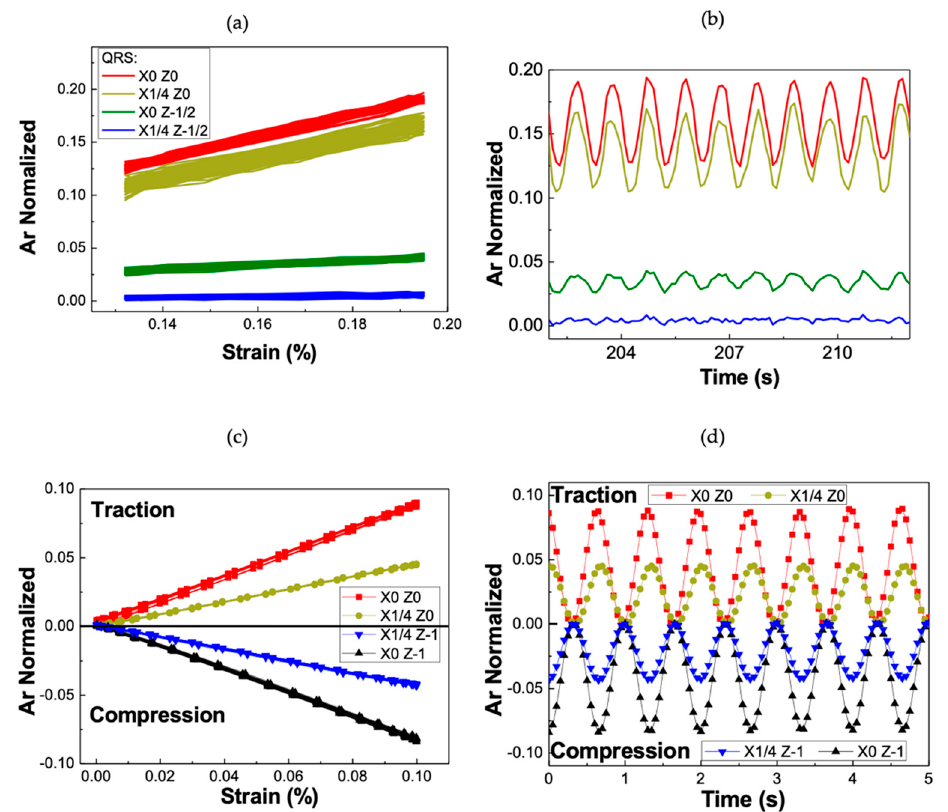
Figure 5. Electrical behavior of four QRS located at four different locations in the CFRP specimen, below the center span (identification X0), or in the middle along the side of the specimen (X1/4), and one ply below the surface (Z0) or near the neutral axis (Z-1.2). ( a ) Normalized electrical resistance (Ar) of the four QRS with maximum strain during dynamic elastic three-points bending test. ( b ) Representation of their electrical response with time according to the deflection of the beam. ( c ) Electrical behavior of the QRS located on the compression side, (X0; Z-1) and (X1/4; Z-1), or the tension side, (X0; Z0) and (X1/4; Z0), during the dynamic three-points bending test. ( d ) Representation of their electrical response associated with time for a given deflection.